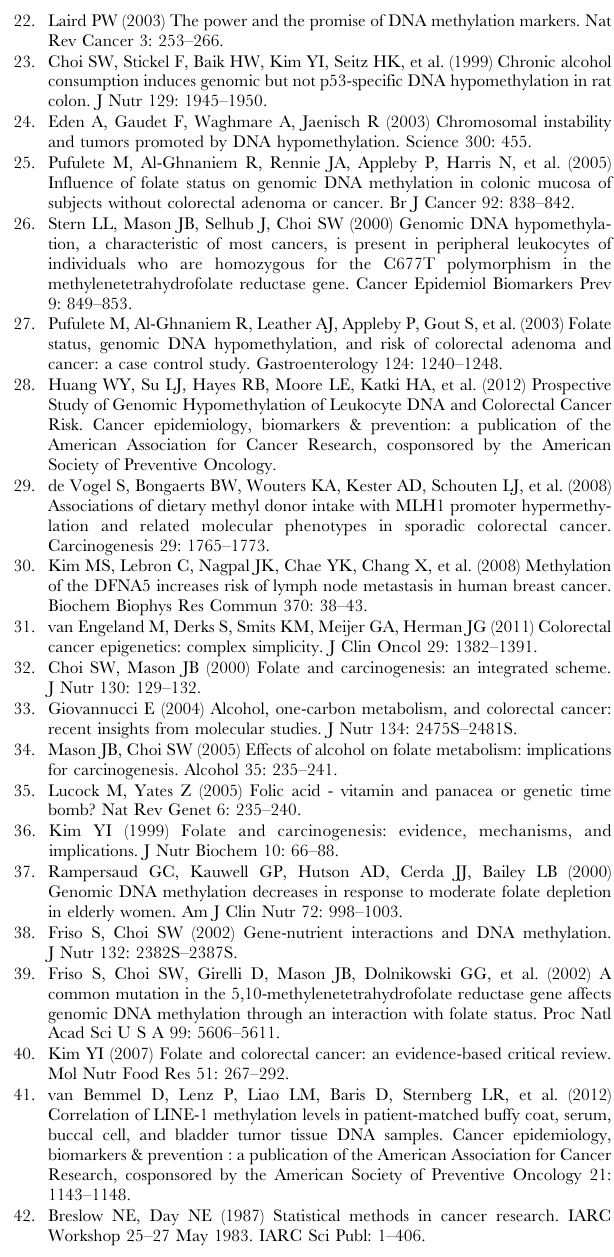
Table S3 Association of one-carbon metabolism and colorectal cancer-related factors with percent genomic DNA methylation levels among